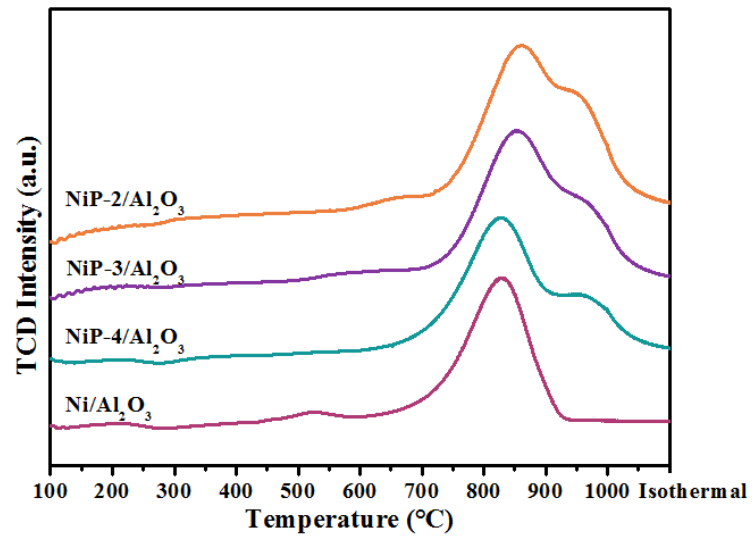
Figure 4. H 2 -TPR profiles of reduced Ni/Al 2 O 3 and NiP-x/Al 2 O 3 catalysts.